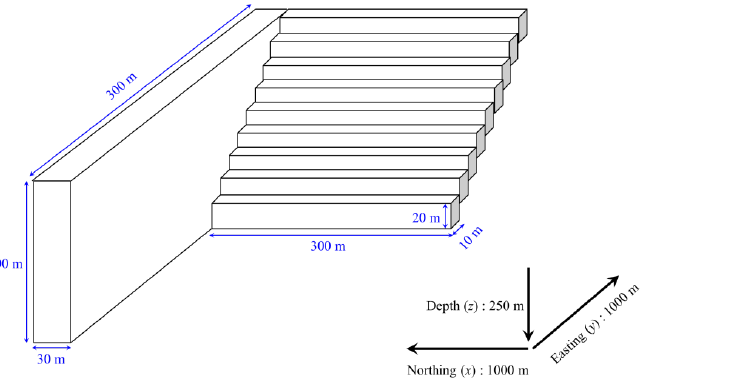
Figure 9. A synthetic two-dike model with a west-dipping dike striking north-south and a vertical dike striking east-west.